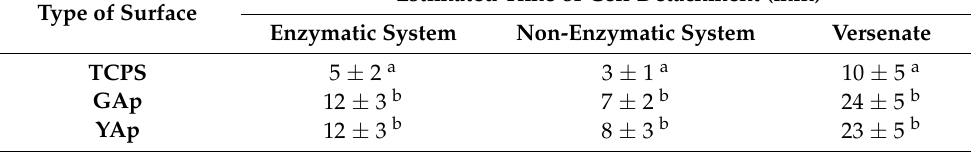
Table 2. The time of cell detachment in relation to the type of growth surface. The averaged time of cell detachment (min) from each of the substratum ± SD is given for enzymatic system and non-enzymatic system, and for versenate. The means with unlike superscript letters are significantly different (for a and b p <